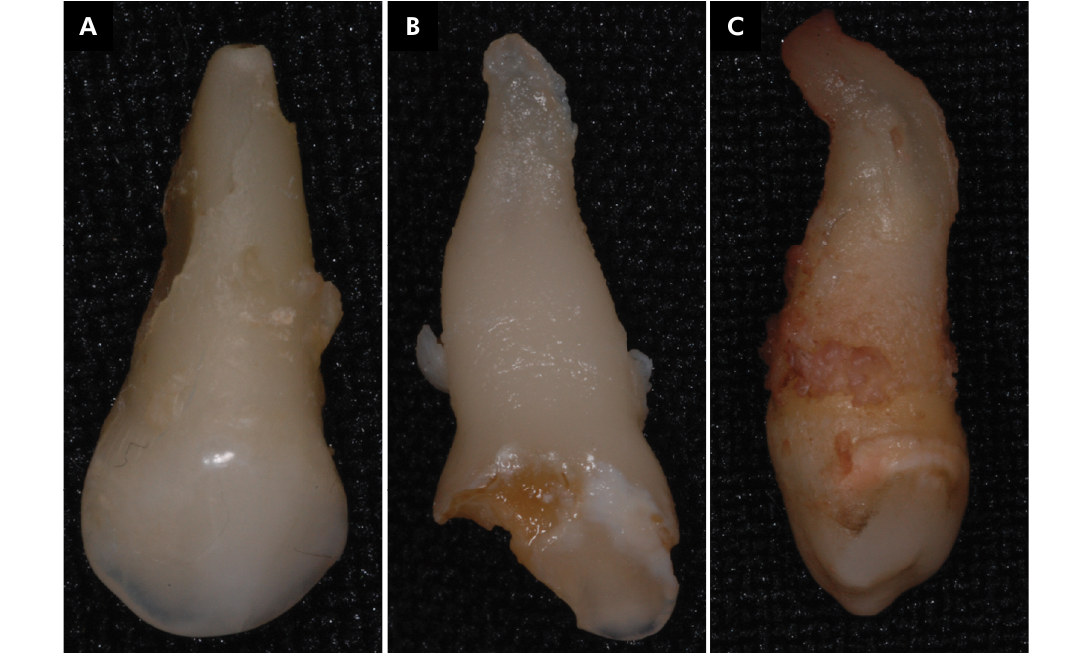
Figure 1. Macroscopic image of group I (deciduous teeth with physiologic root resorption), group II (deciduous teeth with inflammatory pathological root resorption, and group III (permanent teeth, control group) in the buccal